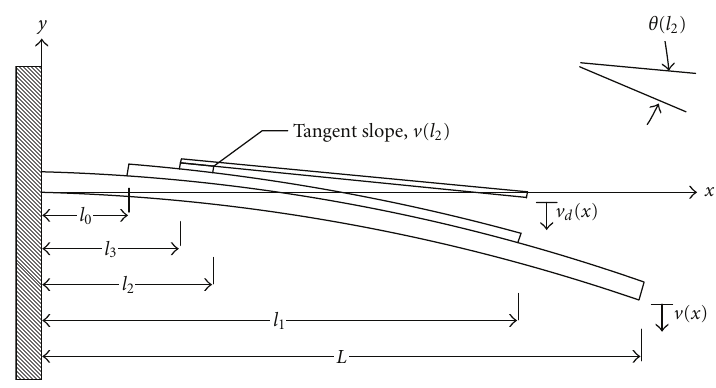
Figure 3: Schematic diagram for sensor model